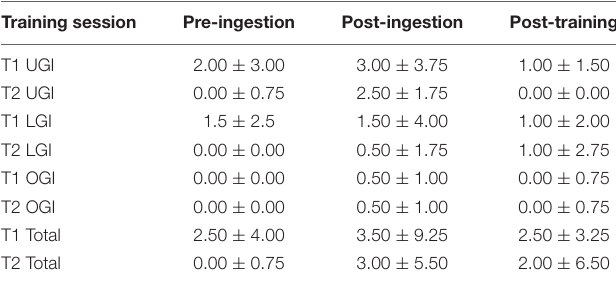
TABLE 8 | Gastrointestinal symptoms quantified during key training sessions during the team holding camp. Training